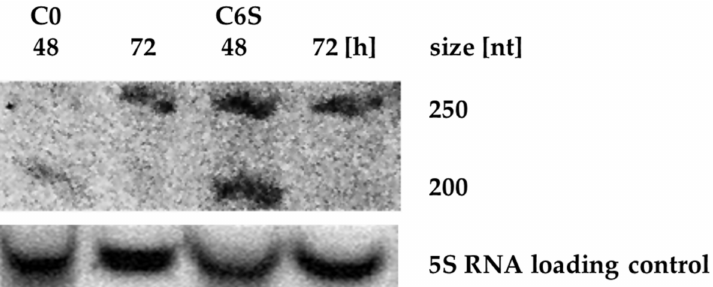
Figure 3. Northern blot analysis of scr3559 RNA levels in C0 and C6S strain. The product at about 250 nt likely corresponds to the pre-scr3559 RNA. The processed scr3559 RNA (192 nt) could be seen only in 48 h-old cells of both C0 and C6S strains.